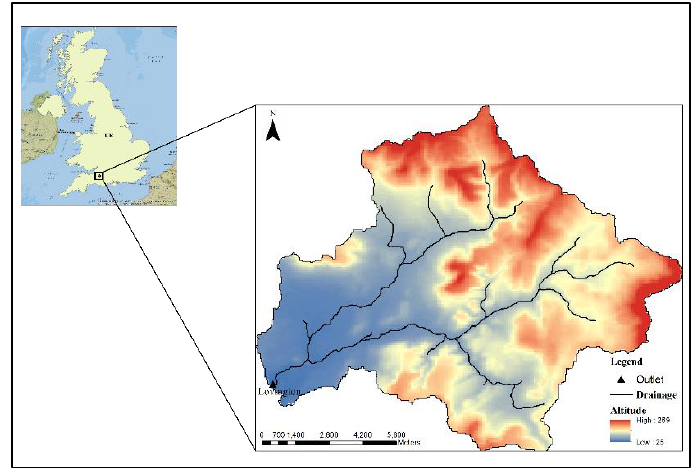
Figure 1. Brue catchment.